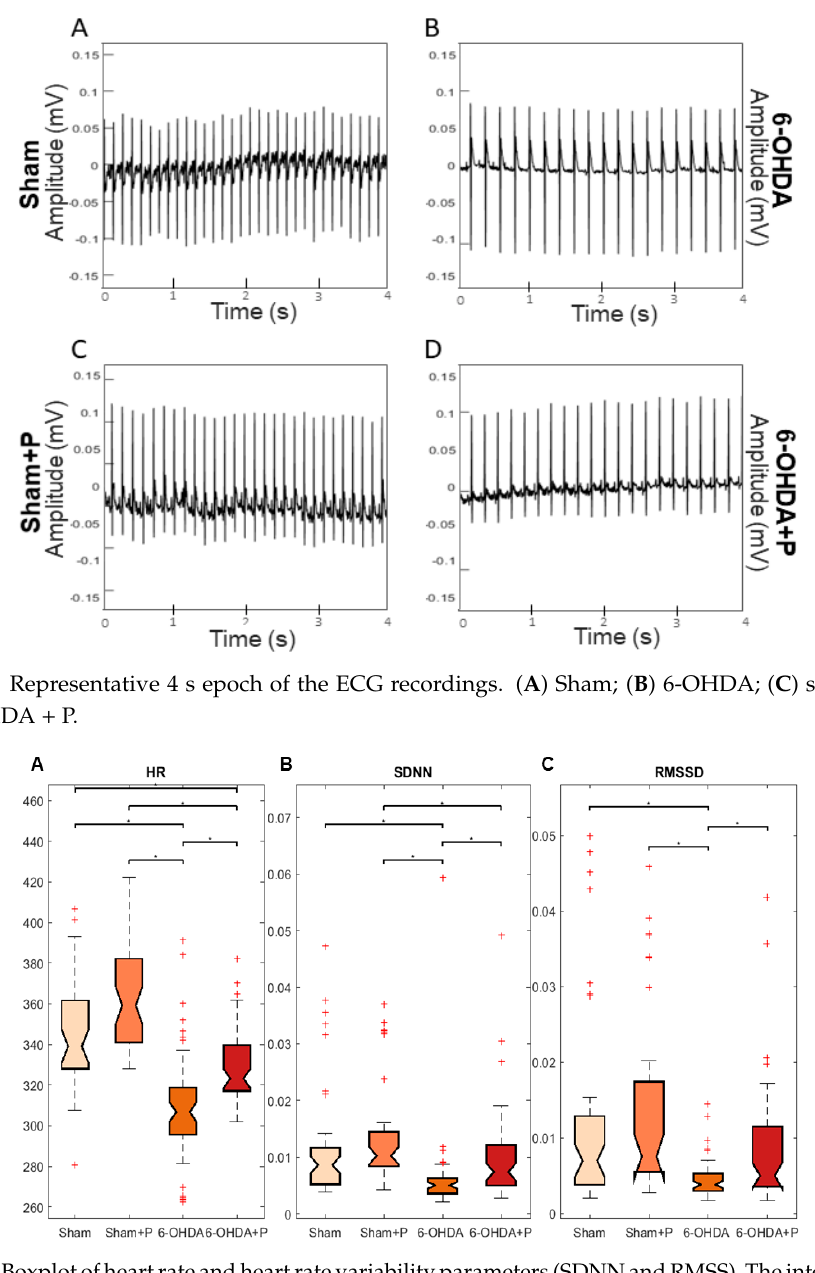
Figure 5. Boxplot of heart rate and heart rate variability parameters (SDNN and RMSS). The interquartile range in the graphs is indicated by the size of the boxes ; the confidence interval for median is represented by the chamfer; the statistically significant di ff erence between two groups is indicated by the asterisks; data with values outside the interquartile range are represented by the red ‘ + ’ symbol. Median and confidence interval for HR, SDNN, and RMSSD were as follows: ( A ) HR: 339.1 ± 8.3 (sham), 359.2 ± 9.3 (sham + P), 306.7 ± 4.8 (6-OHDA), 323.2 ± 4.8 (6-OHDA + P); ( B ) SDNN: 0.008632 ± 0.001508 (sham), 0.01025 ± 0.00154 (sham + P), 0.005022 ± 0.000605 (6-OHDA), 0.007386 ± 0.001517 (6-OHDA + P); ( C ) RMSSD: 0.006963 ± 0.002125 (sham), 0.007532 ± 0.003008 (sham + P), 0.003804 ± 0.000501 (6-OHDA), 0.00499 ± 0.001705 (6-OHDA +